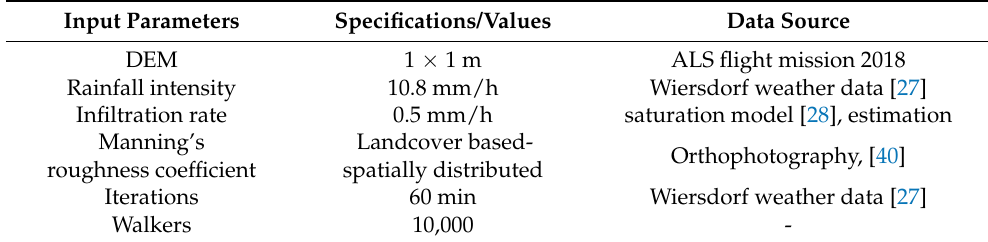
Table 1. Crucial model input parameters used with r.sim.water.